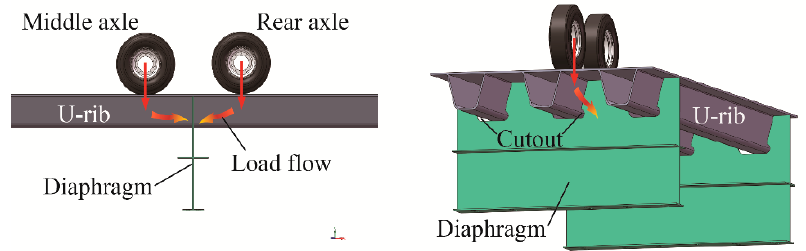
Figure 6. The most unfavorable load case and stress flow.